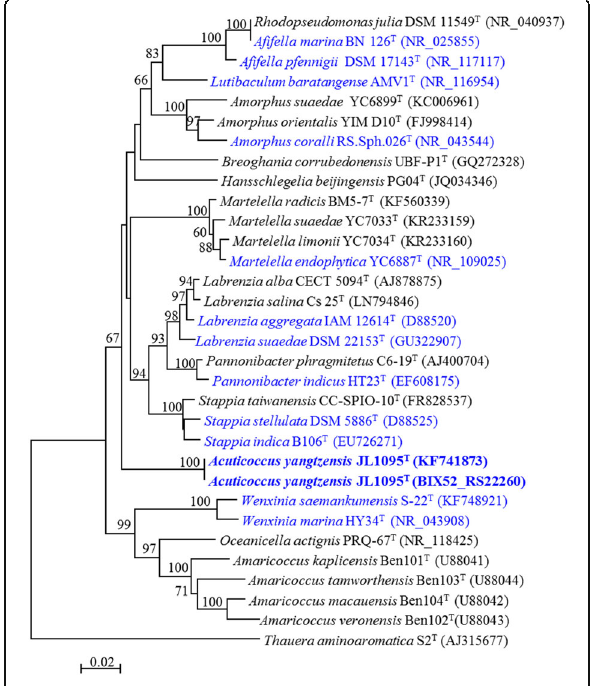
Fig. 2 Phylogenetic tree illustrating the relationship between Acuticoccus yangtzensis JL1095 T and other validly published species. The tree was constructed with MEGA 5.05 software by using the neighbor-joining (NJ) method for 16S rRNA gene sequences. Accession numbers in the GenBank database are shown in parentheses. Reference sequences from relative strains that has been sequenced and obtained a public genome are in blue font, while the JL1095 T sequence is in blue bold font. The numbers at the nodes indicate bootstrap percentages based on 1000 replicates; only values higher than 50% are shown. Bar, 0.02 substitutions per nucleotide position. Thauera aminoaromatica S2 T was used to root the